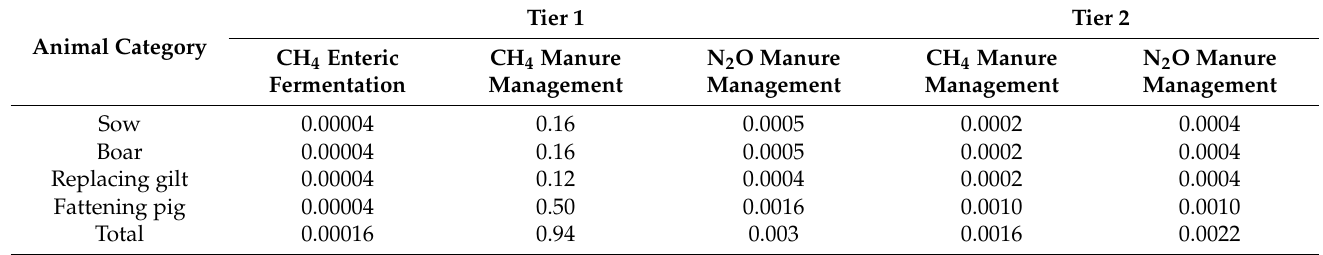
Table 10. Estimated CH 4 emissions derived from enteric fermentation and manure management and N 2 O emissions from manure management using Tier 1 and 2 methodologies per animal within each animal category on a semi-extensive pig farm (Gg CO 2 -eq) .